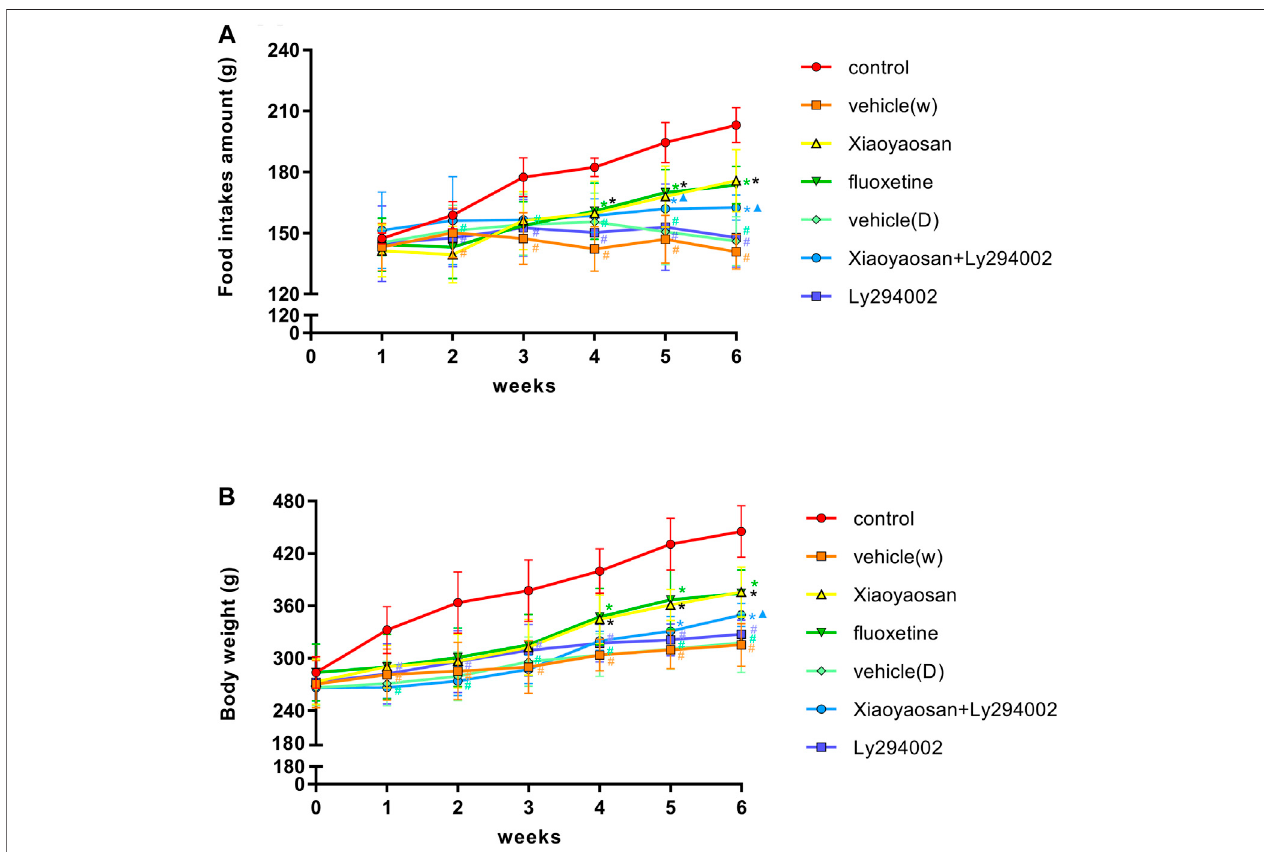
FIGURE2| ChangesinthebodyweightandfoodintakeoftheCUMSrats. (A) Changesinfoodintakefromweekone1toweek6. (B) Changesinbodyweightfrom week 0 to week 6. The data are expressed as the mean ± SD. # p < 0.05 compared to the control group; * p < 0.05 compared to the vehicle (W) group; ▲ p < 0.05 compared to the Ly294002 group, n (cid:2) (cid:2)